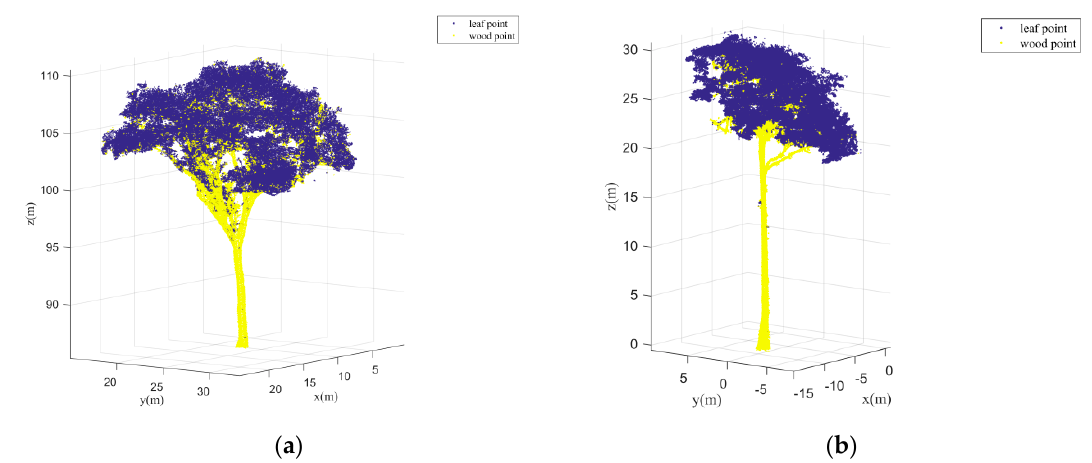
Figure 11. Two individual trees point clouds with label information used for building transfer learning model. ( a ) An individual tree collected by Riegl VZ-400 terrestrial laser scanner; ( b ) An individual tree collected by Riegl VZ-1000 terrestrial laser scanner. Both of these two trees are classified as leaf and wood points manually. Blue points represent leaf points, while yellow points represent wood points.